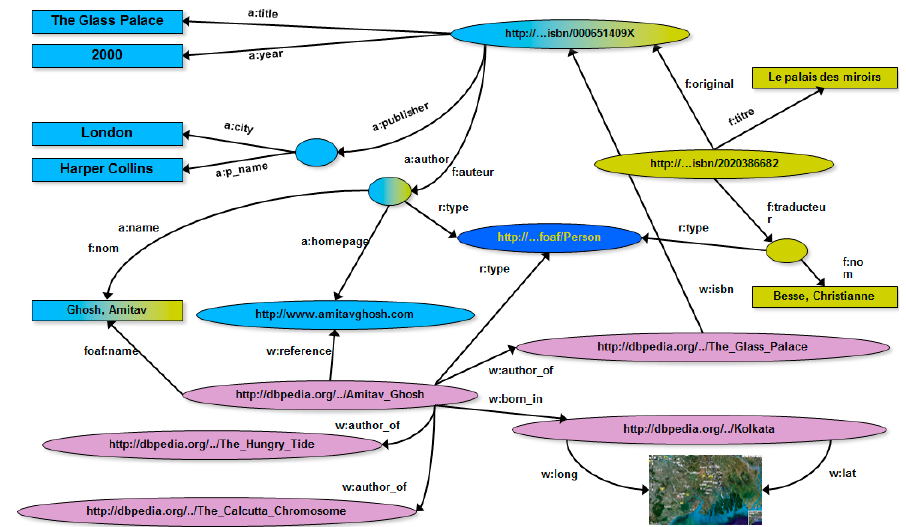
Figure 5. RDF graph obtained via integrating the RDF graph of Figure 4 with Wikipedia knowledge extracted via DBpedia [41].